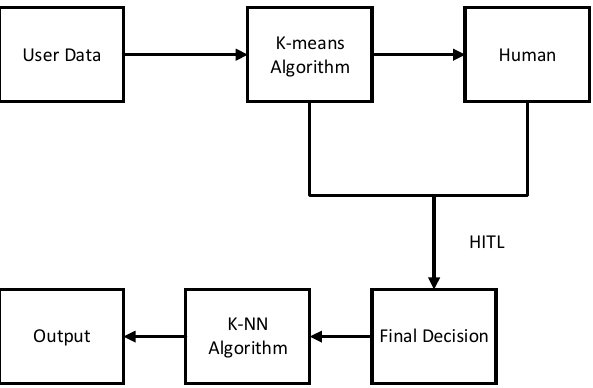
Figure 5. Artificial intelligence (AI) algorithm flow chart based on hybrid artificial intelligence.